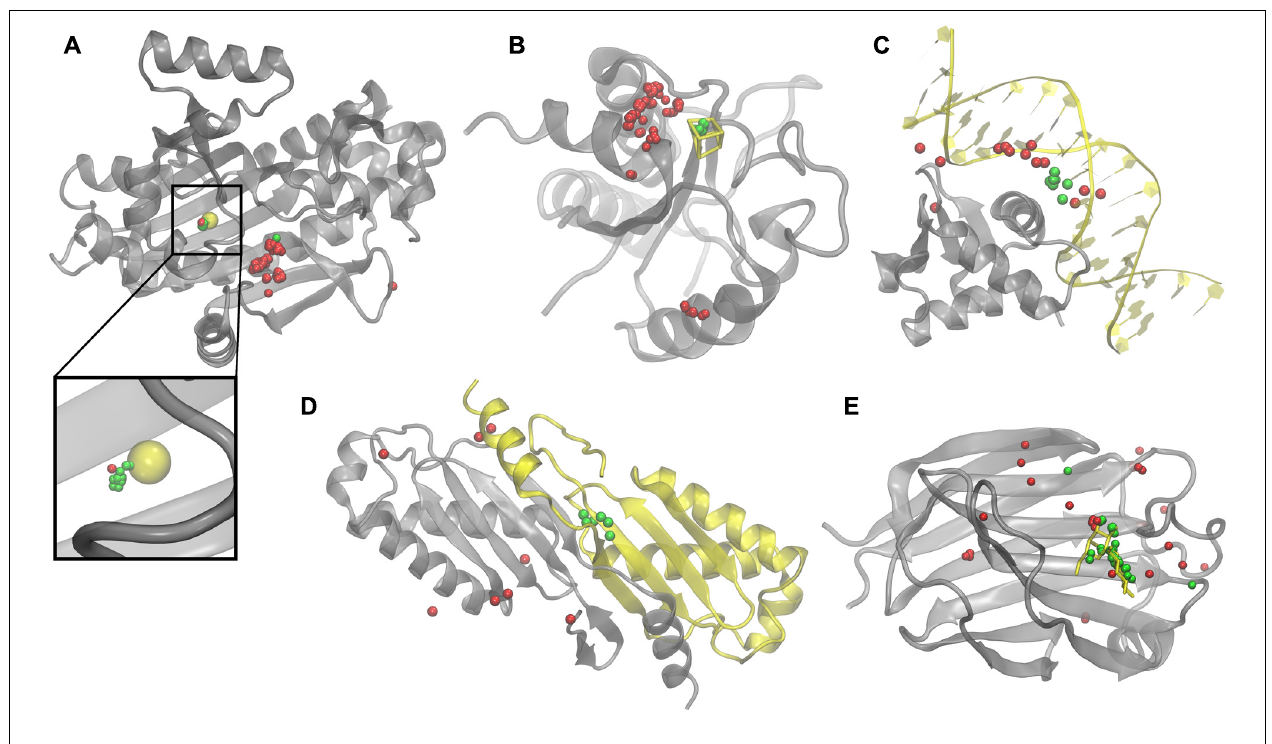
partners are shown in gray and yellow, respectively.Template structures (not shown) are superimposed onto the target; binding sites predicted to be in similar and different locations are colored in green and red,